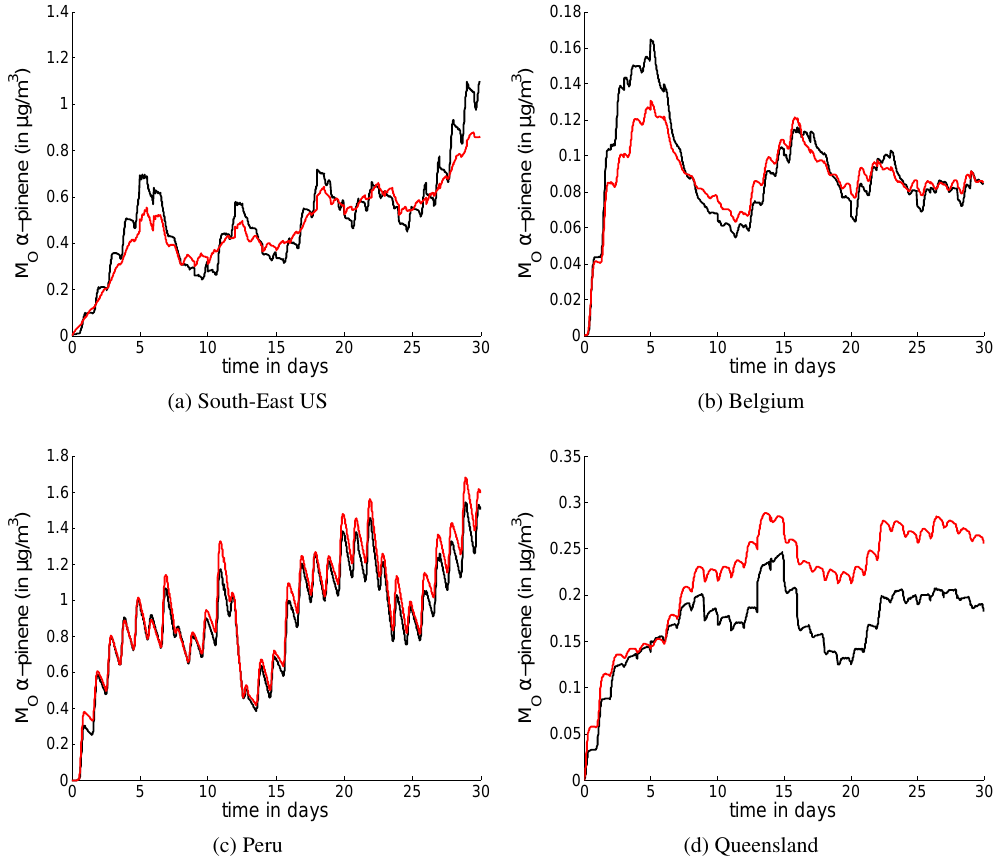
Fig. 11. Example of time evolution of α -pinene SOA in the full BOREAM model (black) versus the parameter model (red) for simulations based on atmospheric conditions simulated with the CTM IMAGESv2, shown here for the month of July.